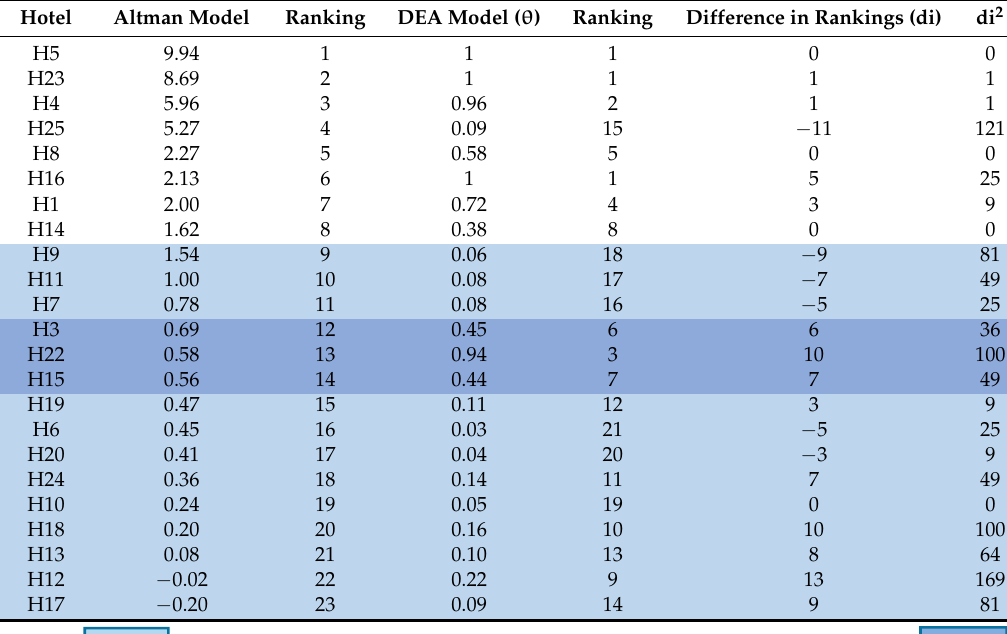
Table 11. Ranking of hotels according to Altman model and DEA model.